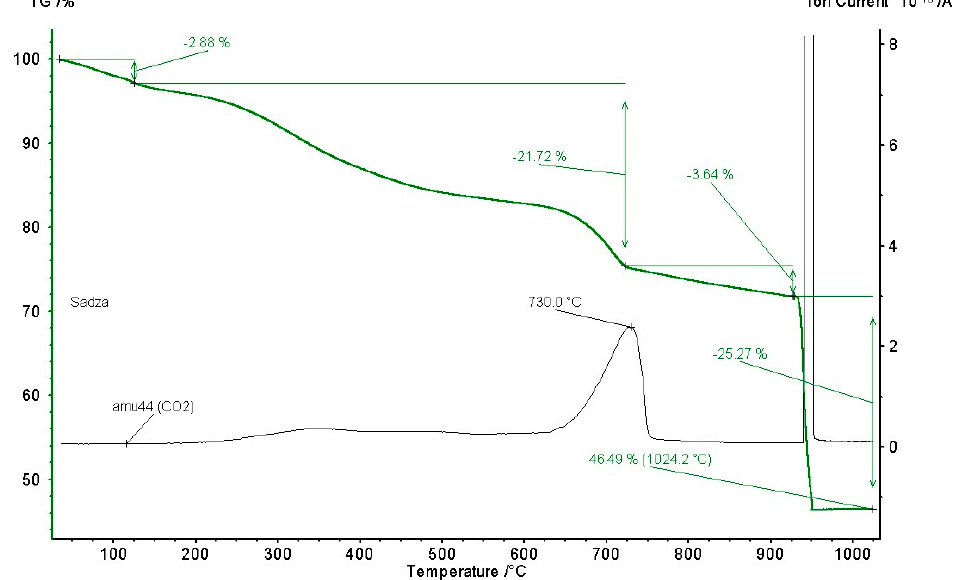
Figure 10. The results of the TG analysis of the soot dust sample.